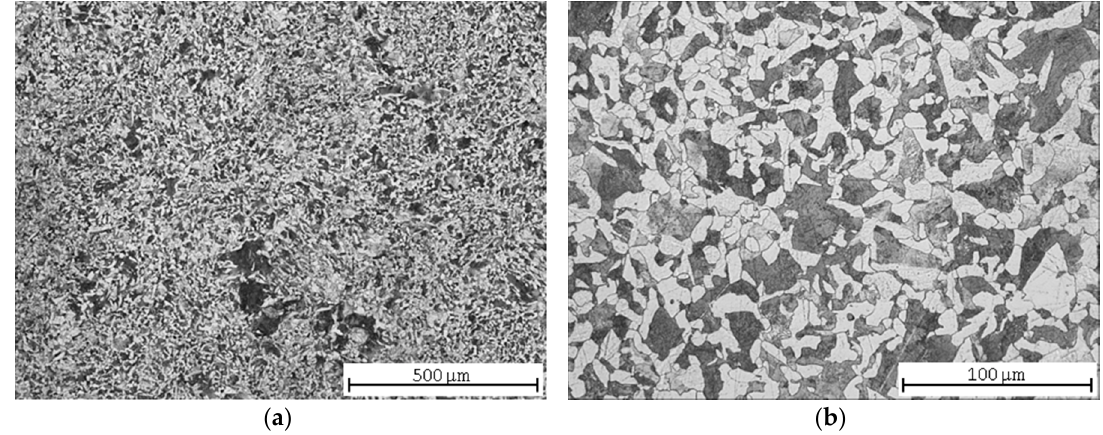
Figure 1. C45 steel microstructures after normalization annealing: ( a ) central part; ( b ) detail.